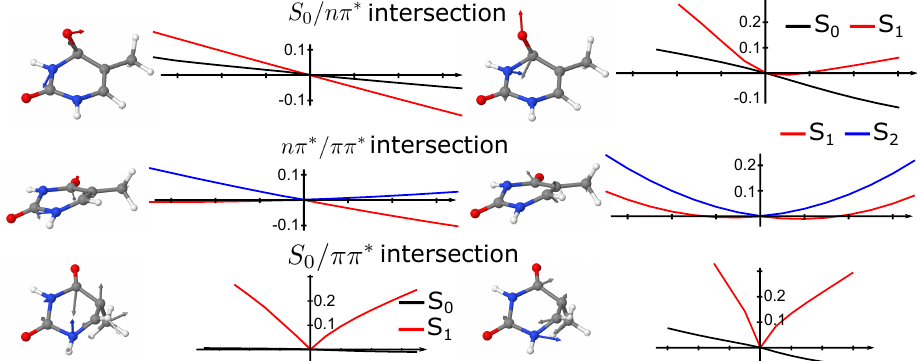
Figure 2. Topology of conical intersections of thymine in the gas phase. ( top ) S0/ n π ∗ intersection, ( middle ), n π ∗ / ππ ∗ intersection and ( bottom ) n π ∗ / ππ ∗ intersection. Structures and graphs corre- sponds to the gradient difference vector and the PES along that coordinate ( left ) and non-adiabatic coupling vector ( right